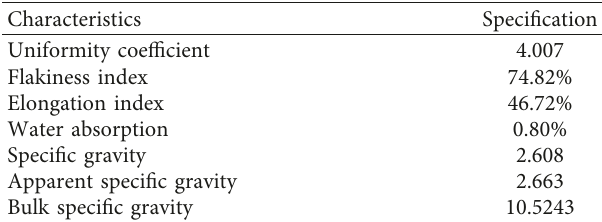
Table 4: Properties of coarse